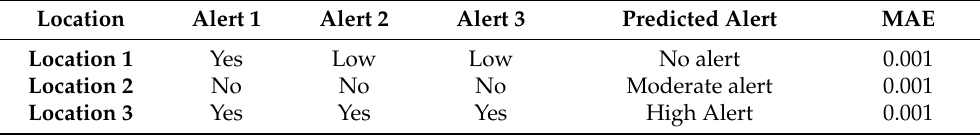
Figure 7. KNIME ANN-MLP algorithm predicting smoke variable. Plots of smoke versus predicted smoke ( a ), and co versus predicted smoke ( b ). The red area represents the alerting condition.